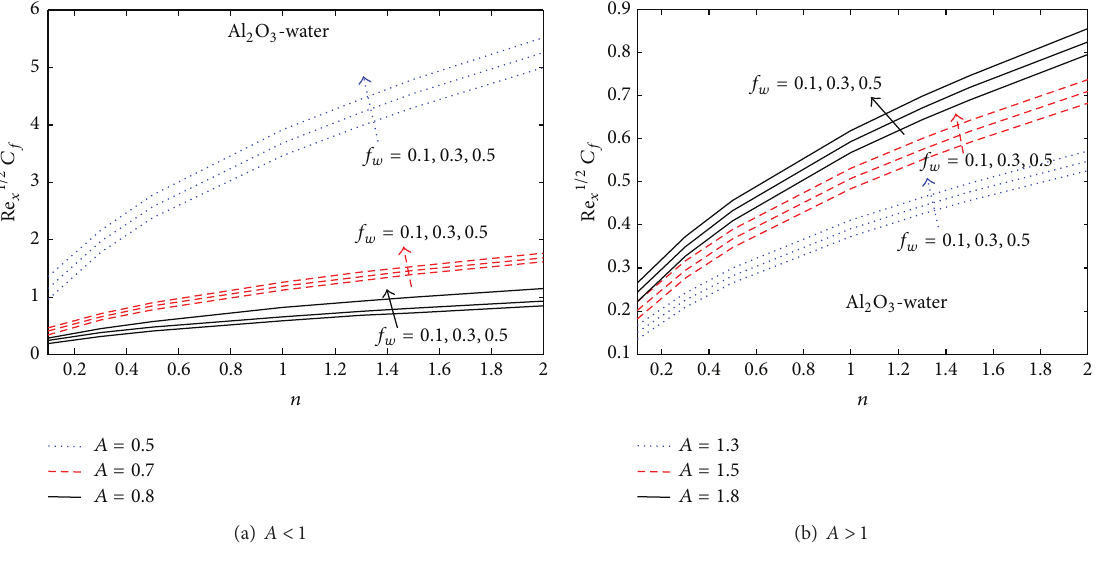
Figure 9: Pr = 6.2 , 𝑀 = 0.5 , 𝑏 = 0.5 , and 𝜙 = 0.1